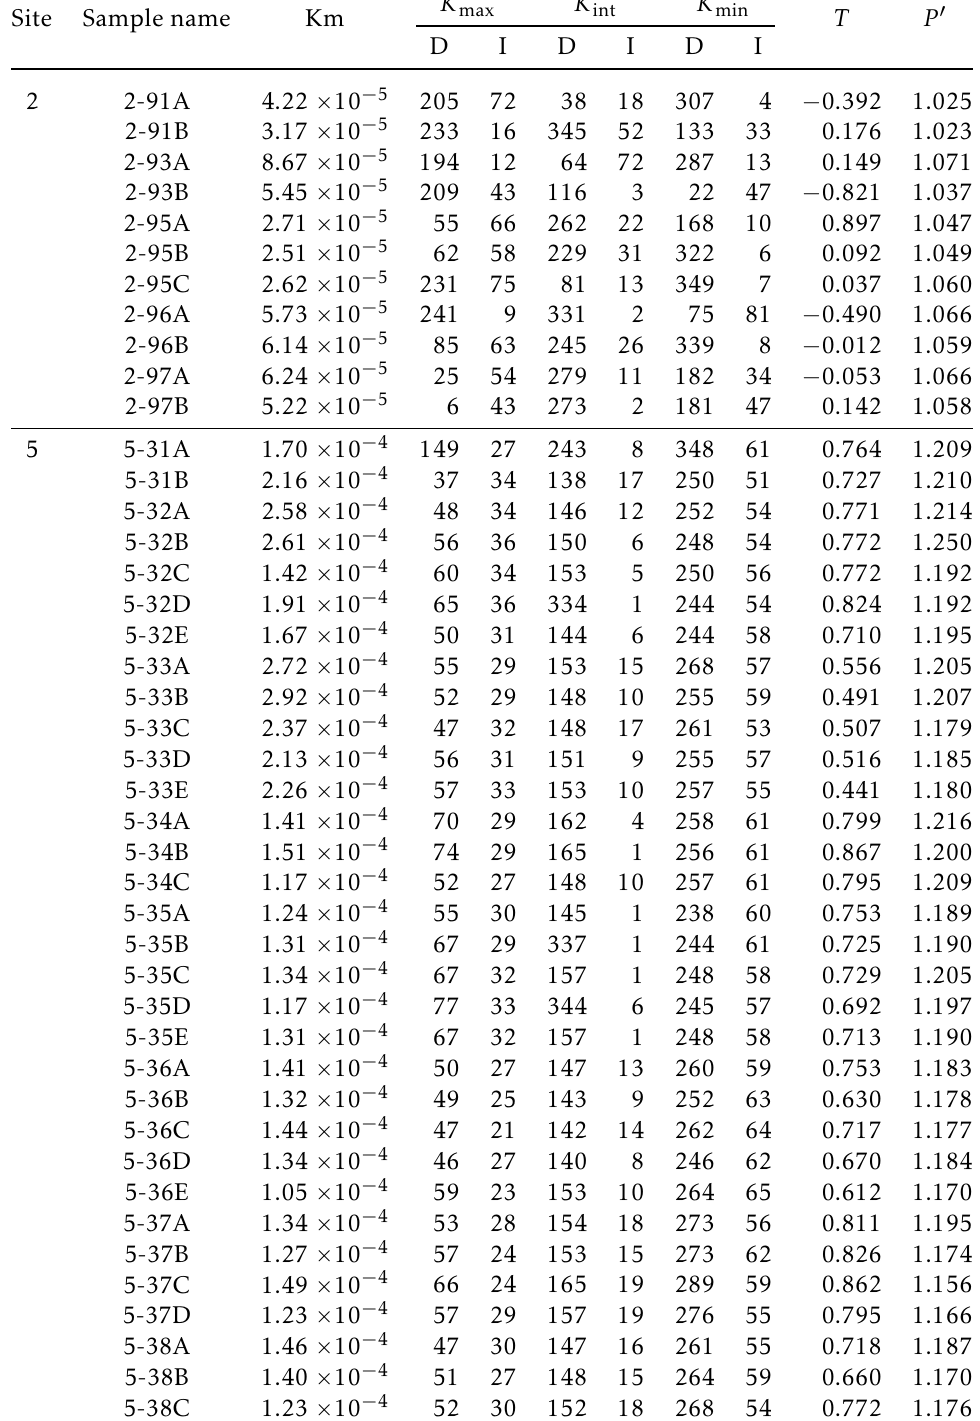
Table A1: Values (Km, in SI) and Directions (D = Declination, I = Inclination, in degrees °) of the principal suscepti- , K , and K ) of samples from Shiroyama lava; T : shape parameter ( T > 0 oblate, T < 0 prolate); bilities ( K max int min P 1 : degree of